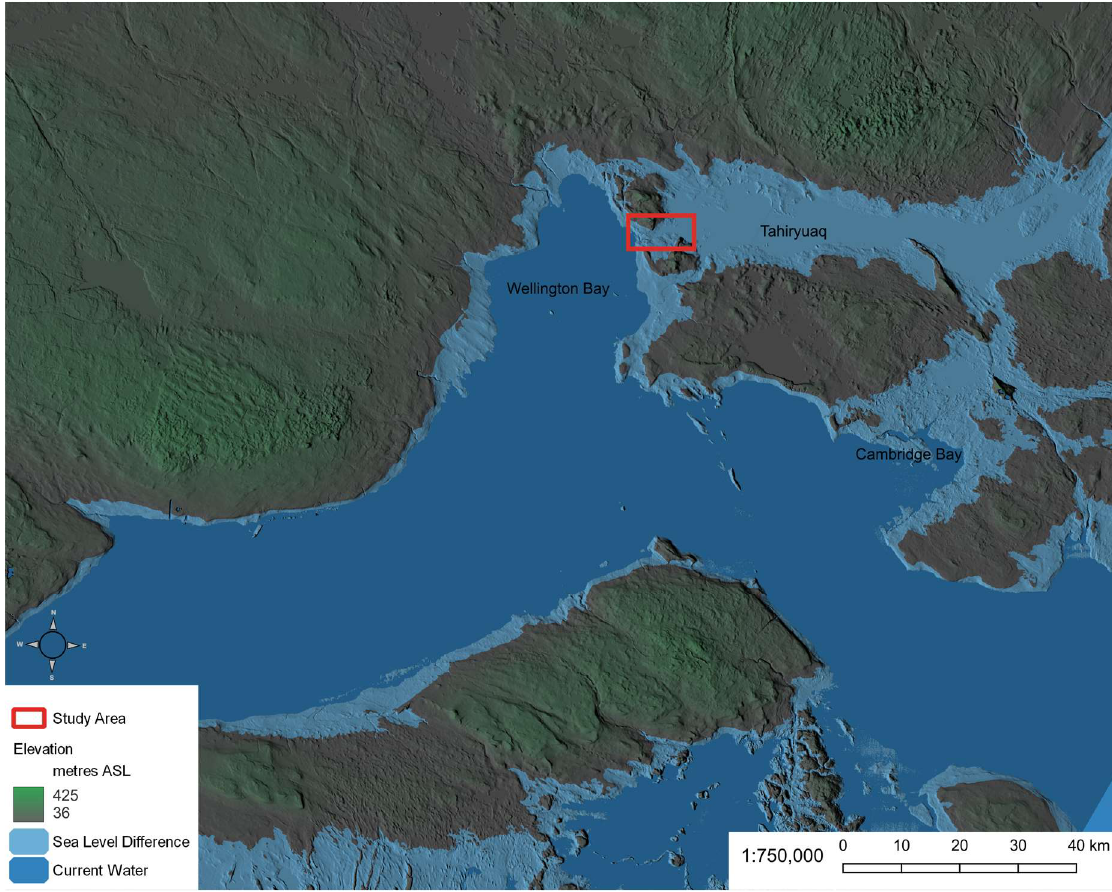
Figure 4. Paleogeography at approximately 5000 cal.